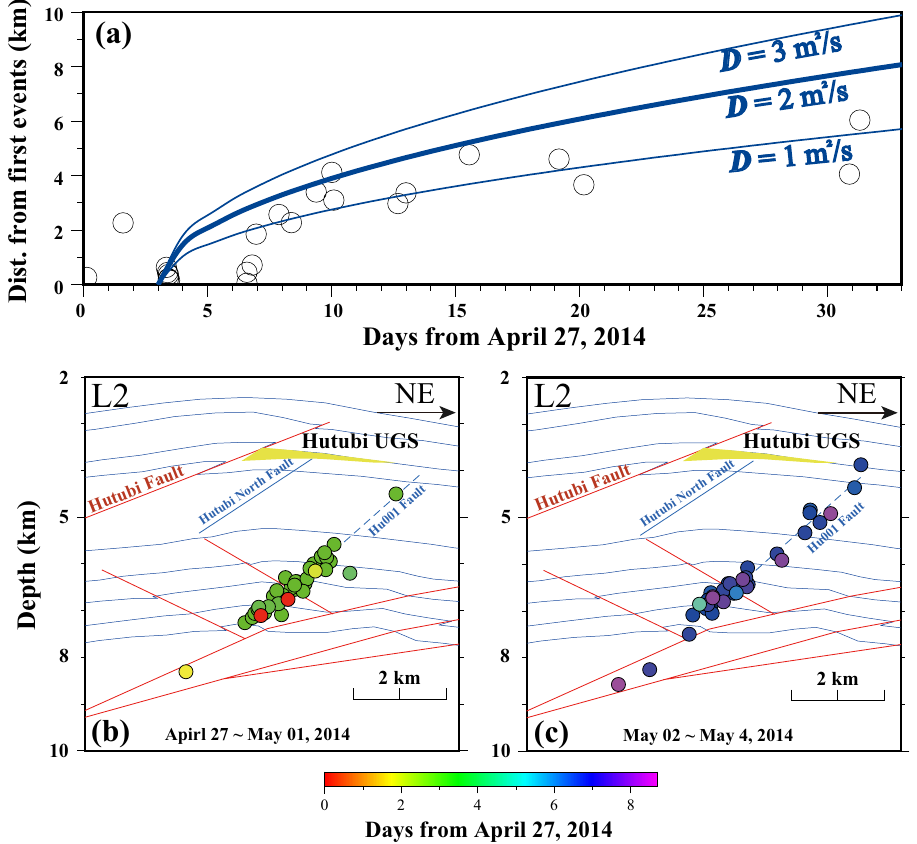
Figure 7. ( a ) The relationship between origin time and distance from the first event in cluster β during the second injection period. The blue lines correspond to diffusion models (Eq. 1) with different hydraulic diffusivity D 50 , and the best fit hydraulic diffusivity (D = 2 m 2 /s) is shown by the bold curve. ( b ) and ( c ) The event distributions at different time periods along L2 (Fig. 5a). Earthquakes are denoted by solid circles and colored by their origin time related to April 27,